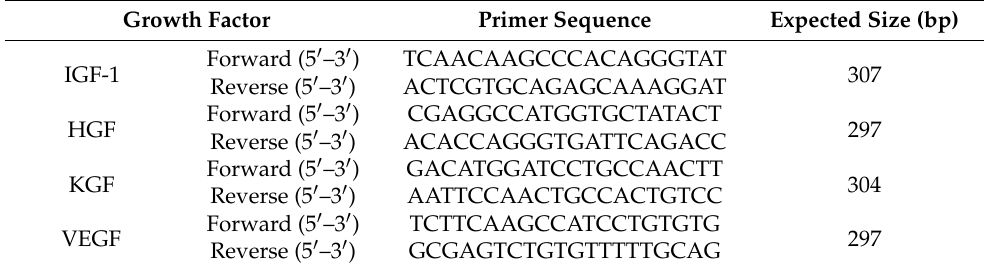
Table 1. Nucleotide sequences of primers and expected sizes of PCR